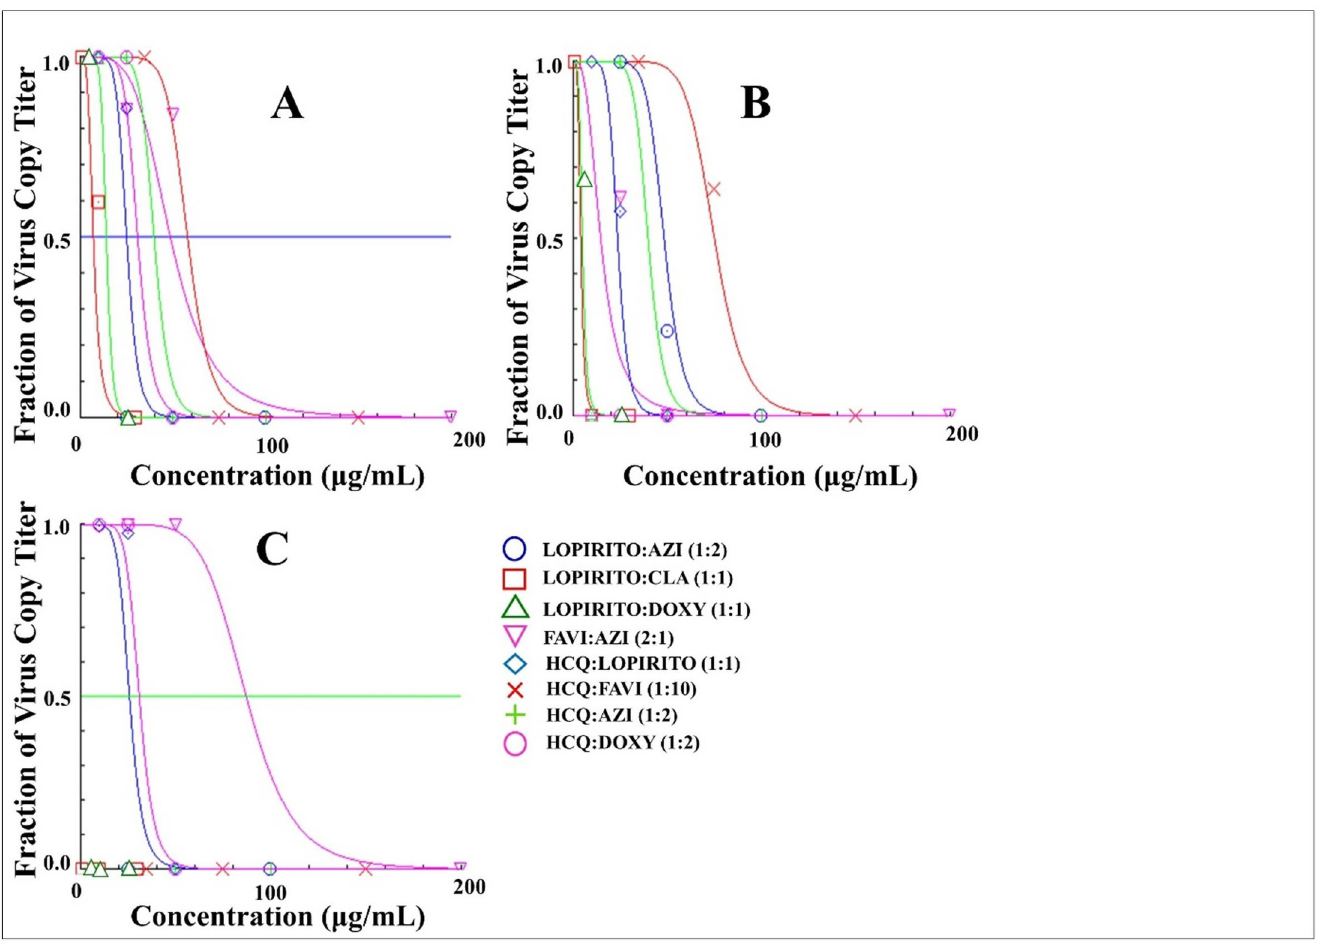
Fig 14. The efficacy (IC 50 ) evaluation of dual combination of Lopinavir-Ritonavir (LOPIRITO), Azithromycin (AZI), Doxycycline (DOXY), Favipiravir (FAVI), Clarithromycin (CLA), and Hydroxychloroquine (HCQ) as a single drug in Vero cells infected with SARS-CoV-2 virus isolates for 24 hours (A), 48 hours (B), and 72 hours (C) analysed using CompuSyn Software at a multiplicity of infection (MoI) value of 0.04.